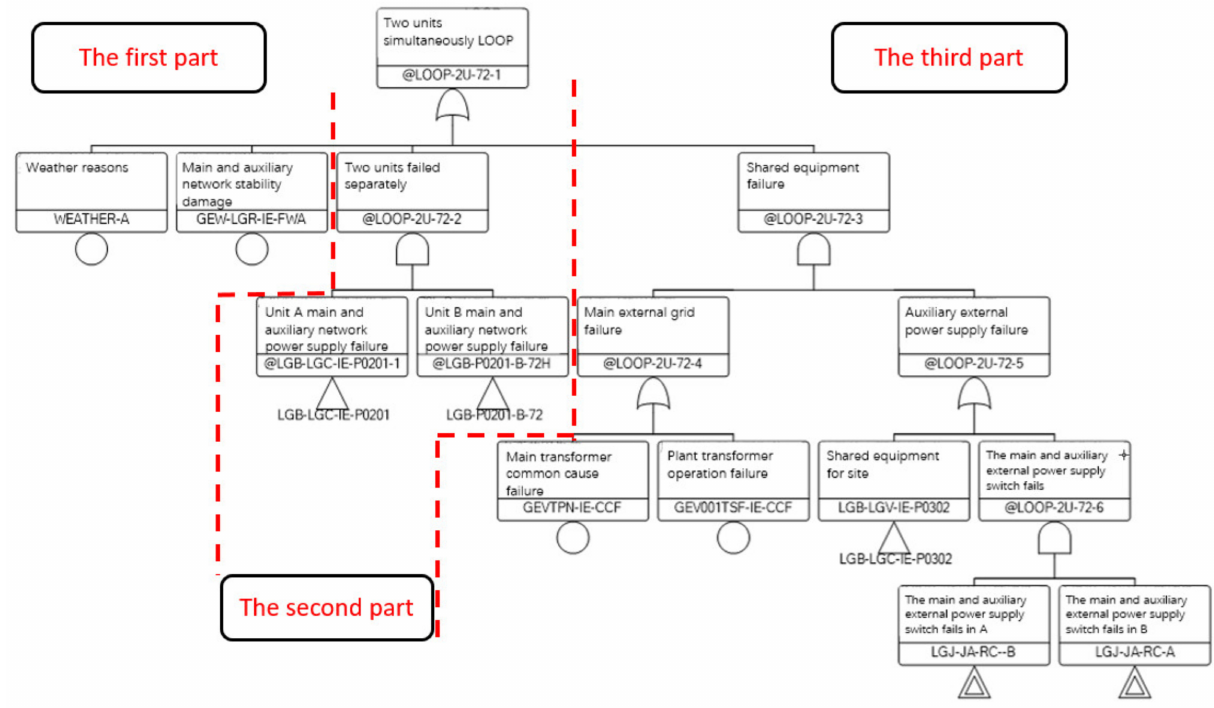
Figure 1. The main fault tree of the LOOP event occurring in both units simultaneously.